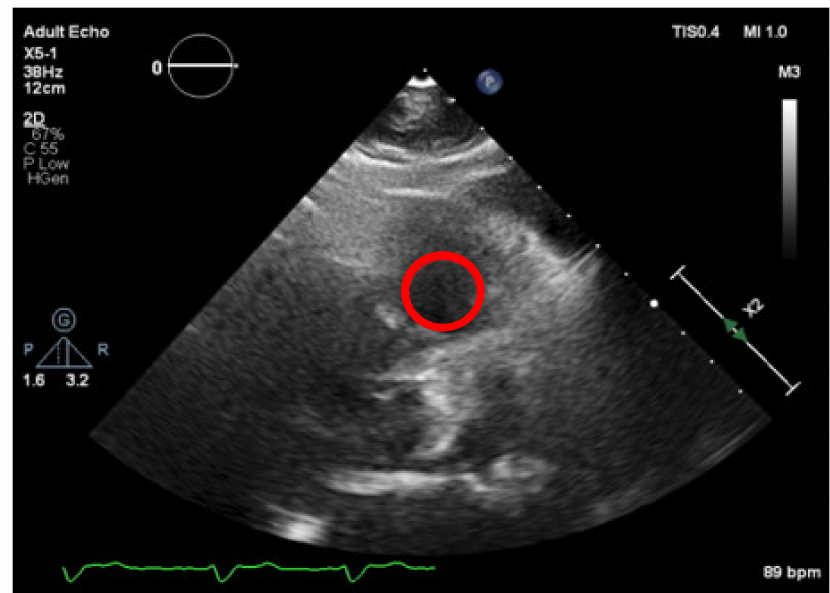
Figure 10. Normalization region (right ventricle cavity).